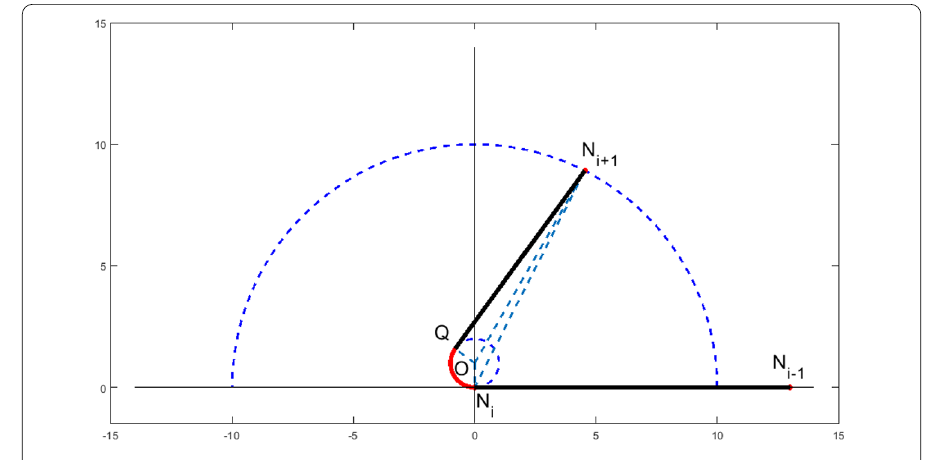
Figure 3 Path analysis of the positive axis in the UV coordinate system